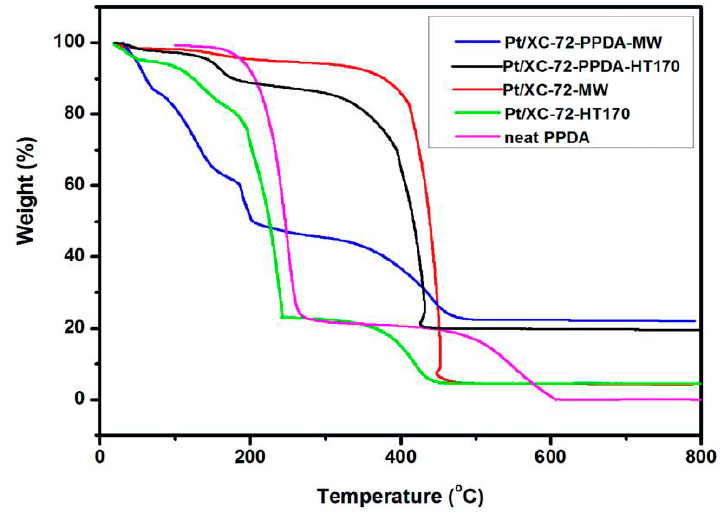
Figure 6. TGA thermograms of neat PPDA and various Pt-loaded supports.